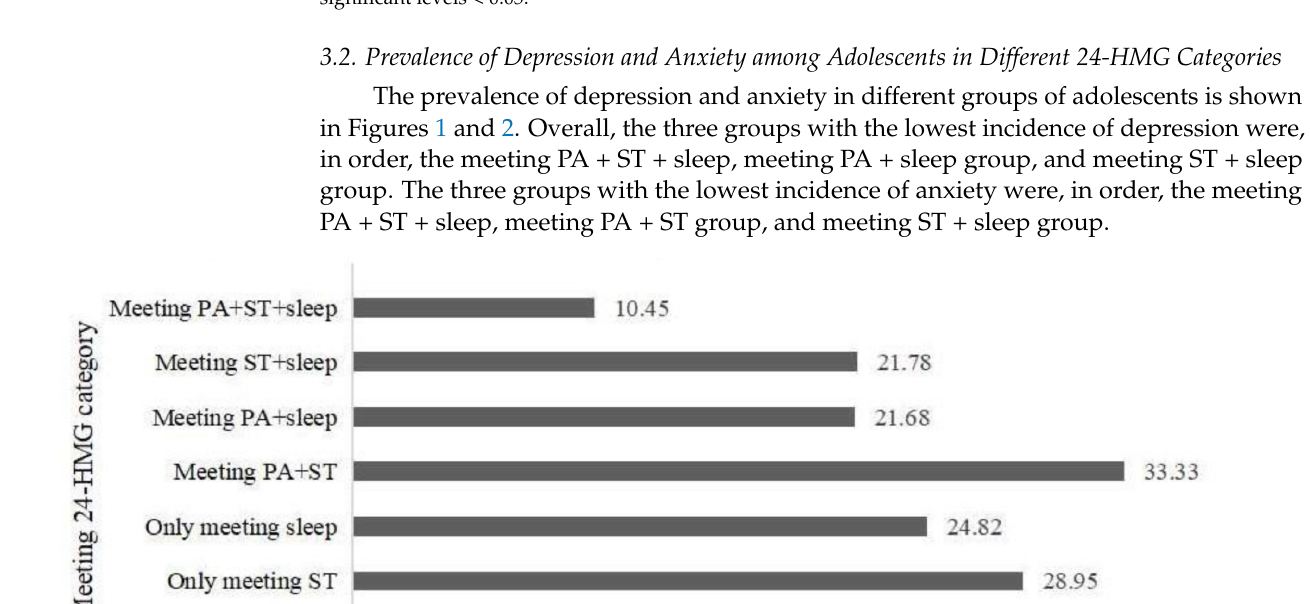
Figure 2. Prevalence of depression in different groups of adolescents. Among boys, the three groups with the lowest prevalence of depression were, in or- der, the meeting PA + ST + sleep group (9.43%), the meeting ST + sleep group (21.15%) and the meeting PA + sleep group (22.68%). Among the girls, the three groups with the lowest prevalence of depression, in order, were the meeting PA + ST group (11.11%), the meeting PA + sleep group (212.50%) and the meeting ST + sleep group (19.56%). Among boys, the three groups with the lowest prevalence of anxiety were, in order, the meeting PA + ST + sleep group (7.55%), the meeting ST + sleep group (22.44%) and the